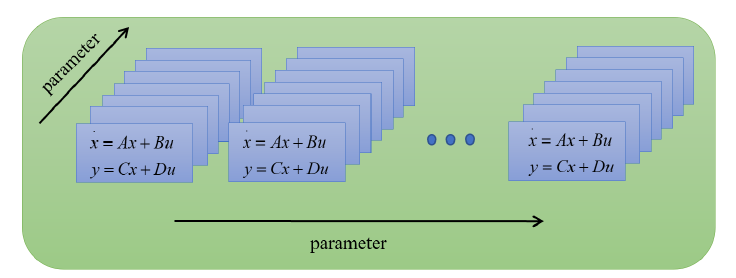
Figure 8. A grid-based LPV model